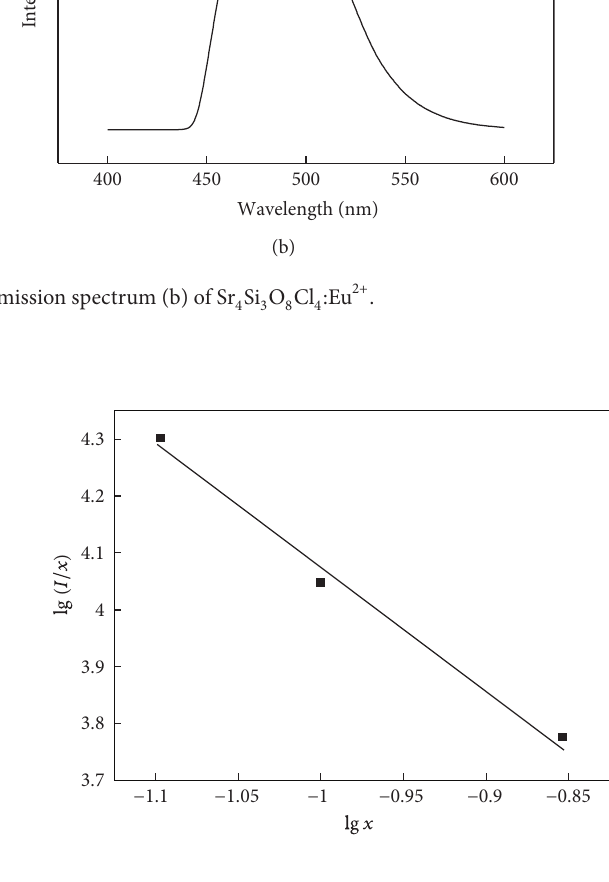
F 4: Relationship between the